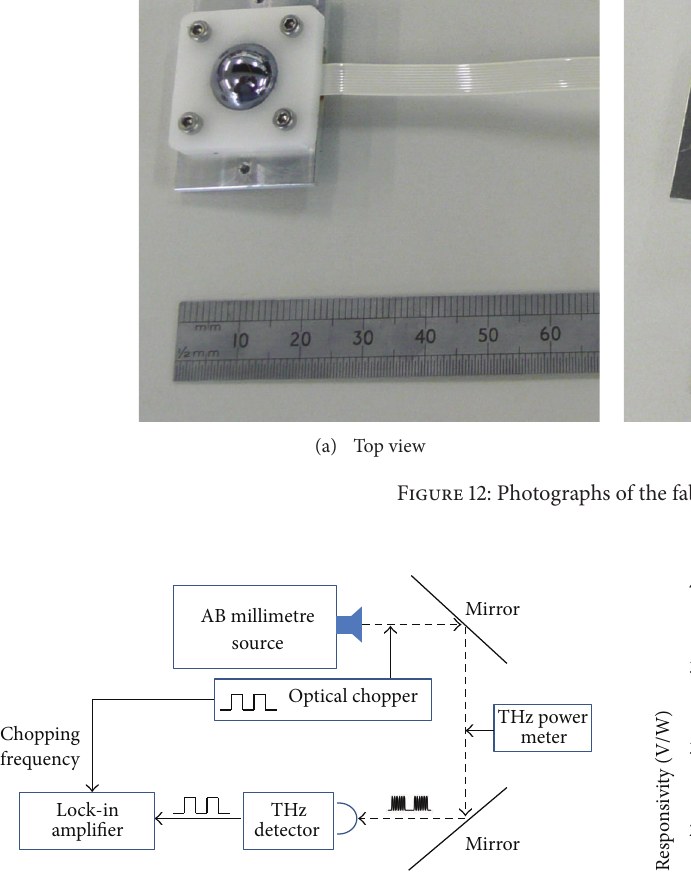
Figure 13: Schematic diagram of responsivity measurement setup.